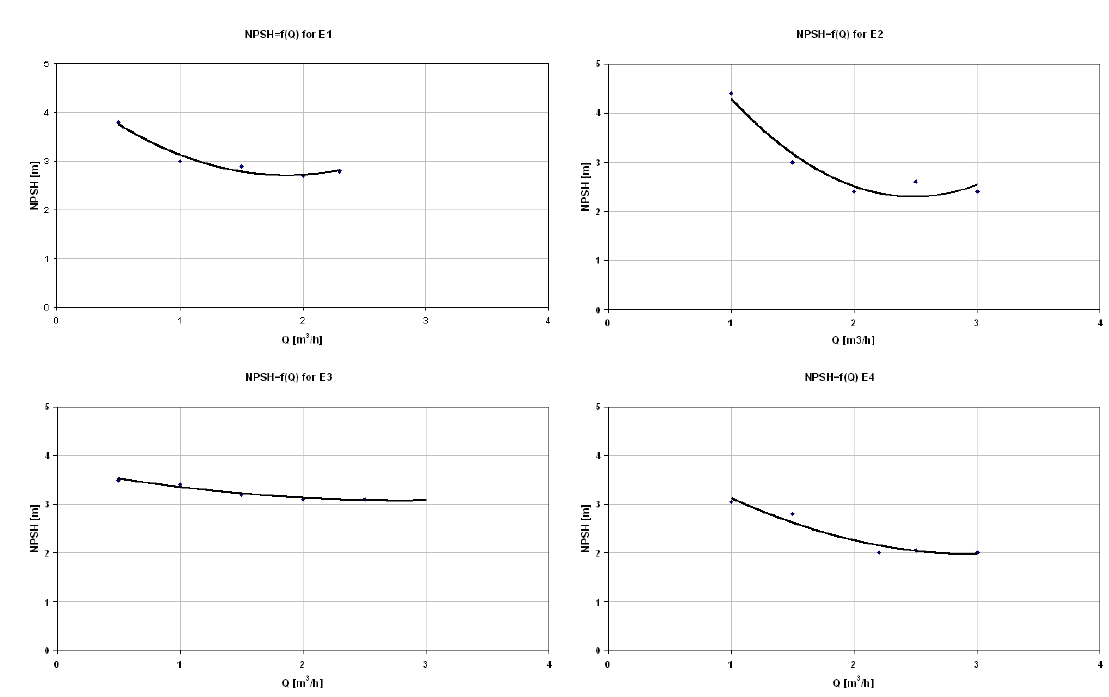
Figure 2. The characteristics of NPSHr